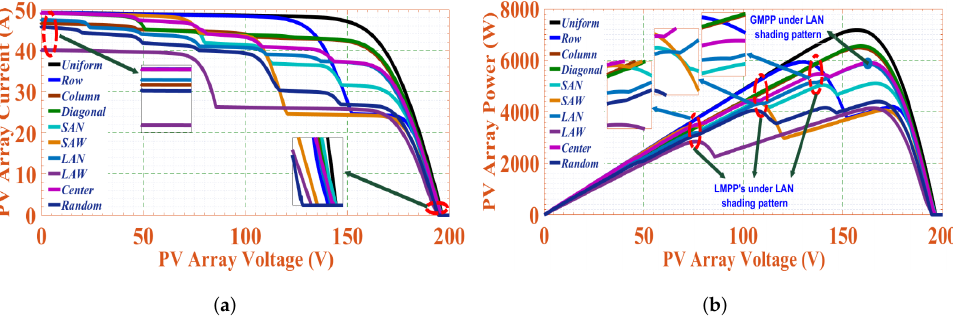
Figure 10. H-C-C-T topology results under various PSCs. ( a ) I-V characteristics, ( b ) P-V characteristics.